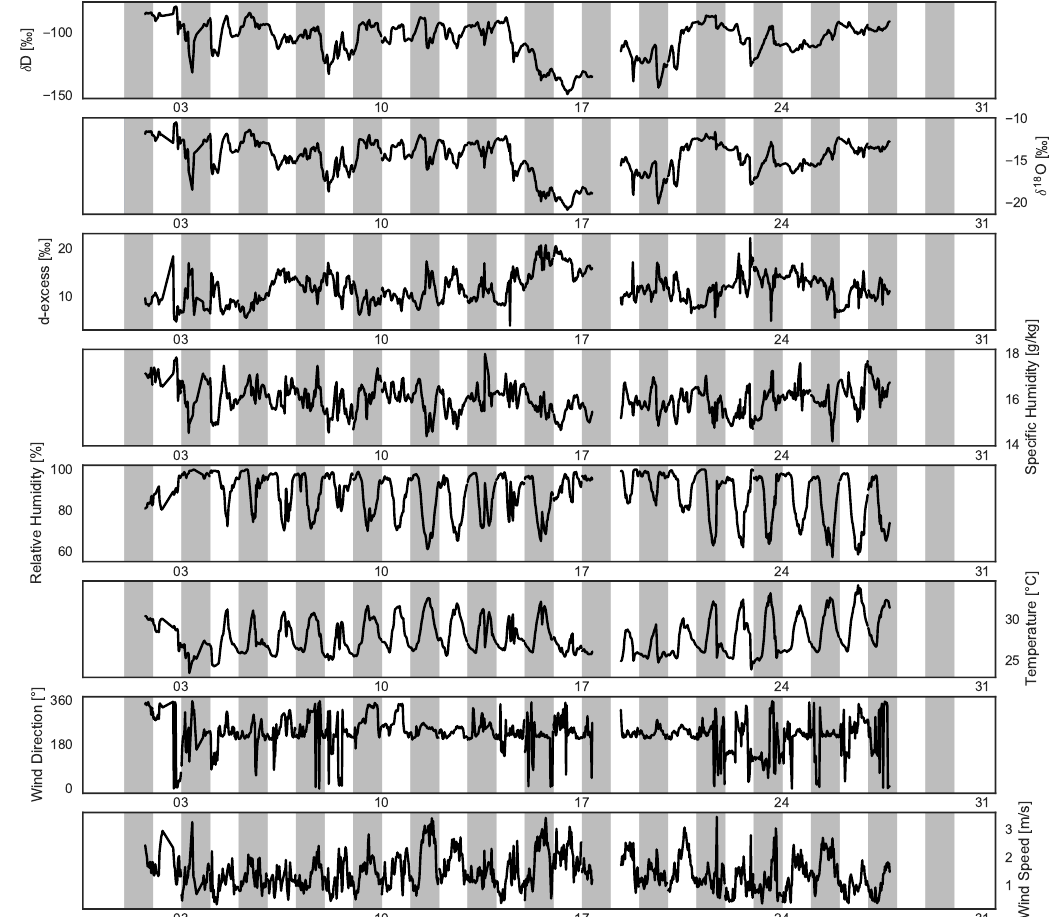
Figure 2. Data measured during the July 2017 campaign at Gaoqiao Mangrove Reserve by the Piccaro L2130-i water vapor isotopic analyzer (upper four panels) and by the nearby weather station (lower four panels). Shaded areas mark the transitions between days (midnight to midnight local time). The ∼ 1-day data gap in the middle was caused by an extended power outage. A wind direction of 0 ◦ corresponds to winds from the